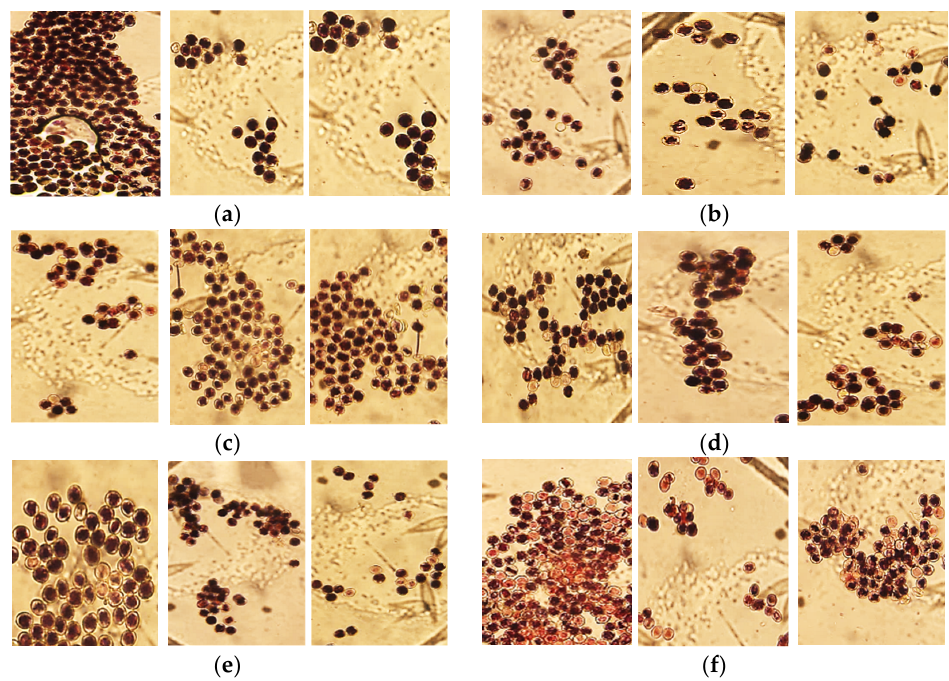
Figure 2. Comparison of pollen viability from storage temperatures 0, 4 and 8 °C (from the left). Storage time: ( a ) 0 days; ( b ) 4 days; ( c ) 8 days; ( d ) 12 days; ( e ) 16 days; ( f ) 20 days. The results indicate that pollen germination increased with caprifig storage (Table 1 and Table S2). Moreover, storage temperature and time affected the germination rate. Pollen germination was higher in the caprifigs stored at 8 ◦ C (43.96%), followed by